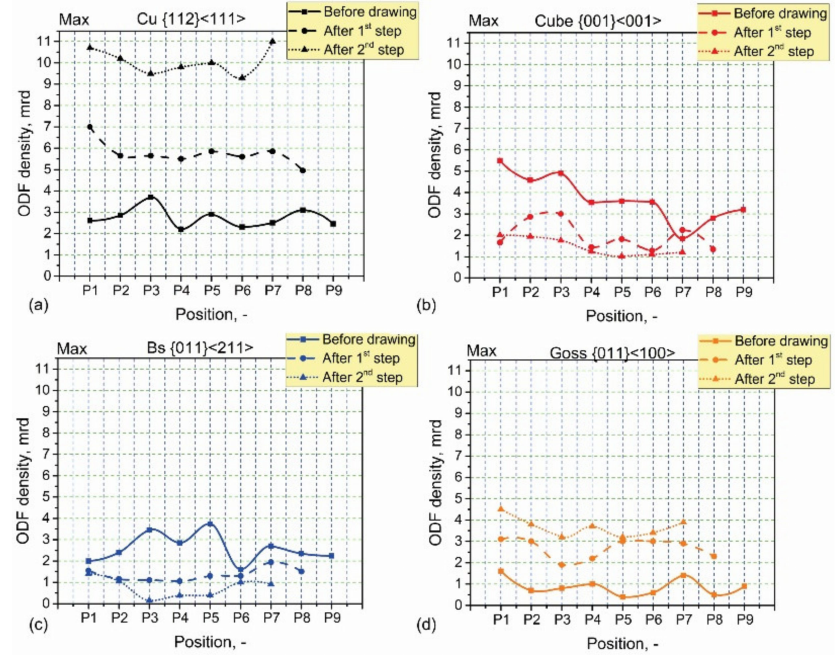
Figure 12. Changes in the texture components over the wall thickness of the tube at max side before and after drawing steps; ( a ) Cu , ( b ) cube , ( c ) Bs , and ( d ) Goss